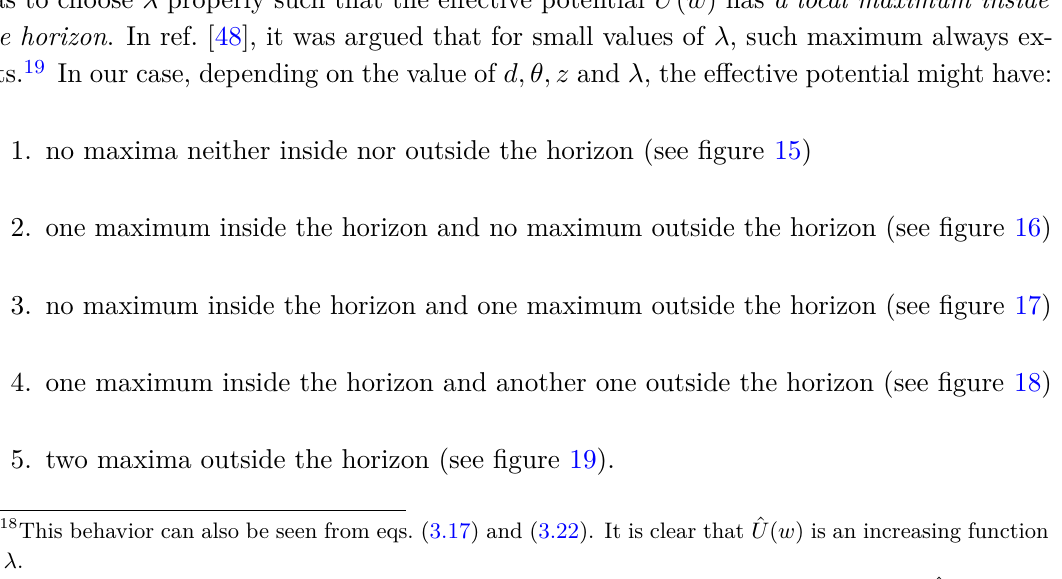
Figure 14 . The growth rate d C gen d = 2 , θ = 0 and z = 1 . Top Right ) d = 3 , θ = 1 and z = 2 . Down Left ) d = 4 , θ = 2 and z = 3 . Down Right ) d = 5 , θ = − 1 and z = 2 . We also plotted it for the case λ = 0 , i.e. volume-complexity, which is indicated by the dashed black curve. We set L = r